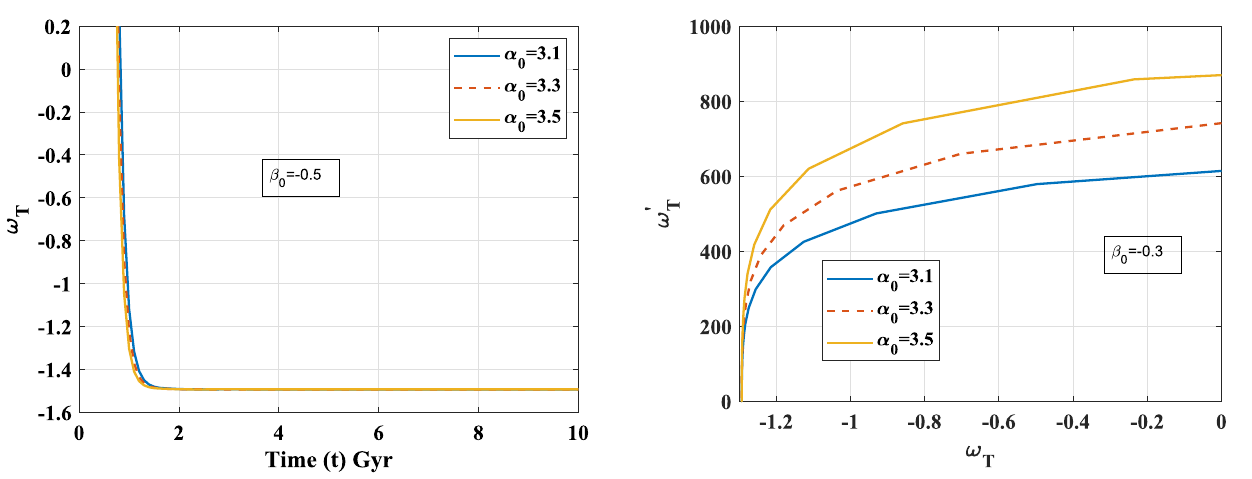
Fig. 9 Plot of EoS parameter ( ω T ) versus time ( t ) for k = 1 . 9, α 1 =